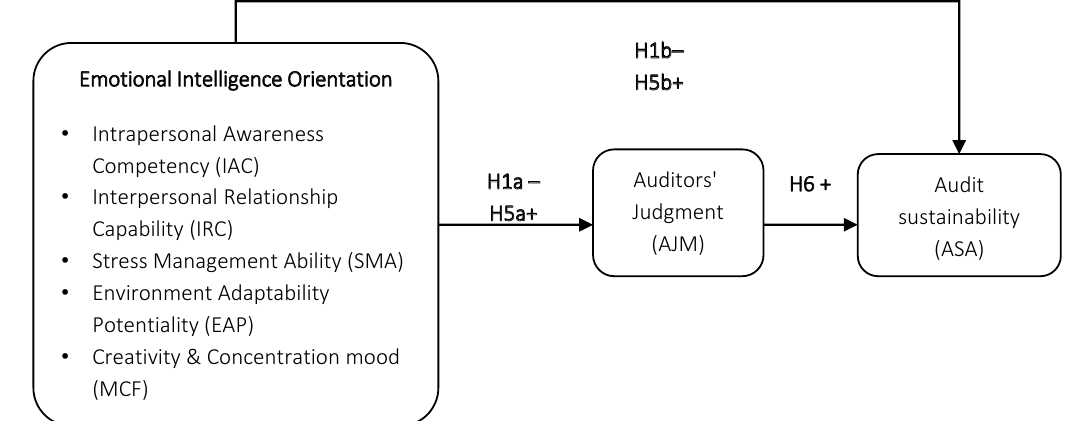
Figure 1. Suggested research